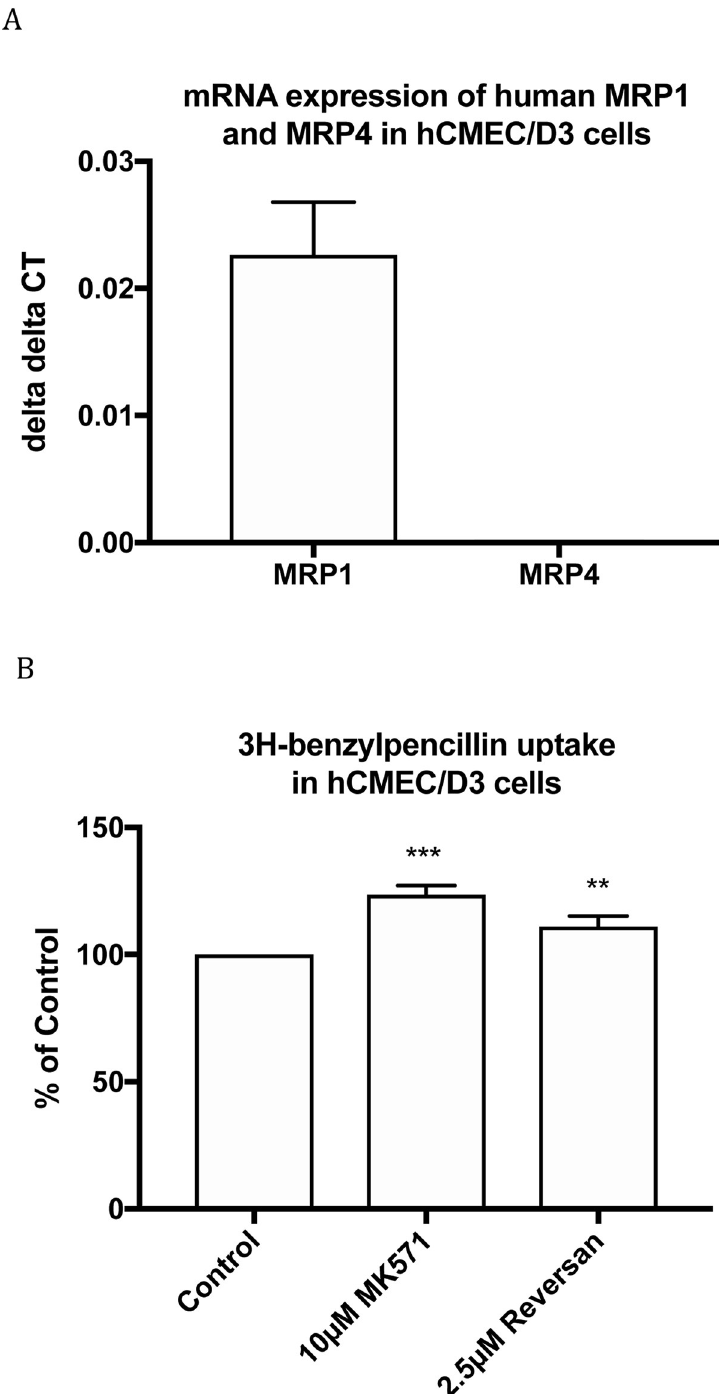
Fig 4. mRNA expression of MRP transporters in hCMEC/D3 cells (A) and [ 3 H]benzylpenicillin uptake in hCMEC/ D3 cells with and without 10 μ M MK 571 and 2.5 μ M reversan(B). Values are means +/- S.E., n = 3–6, each performed in triplicate. �� and ��� indicate significant differences from comparison between different cells at the P < 0.01 and P < 0.001 levels, respectively.